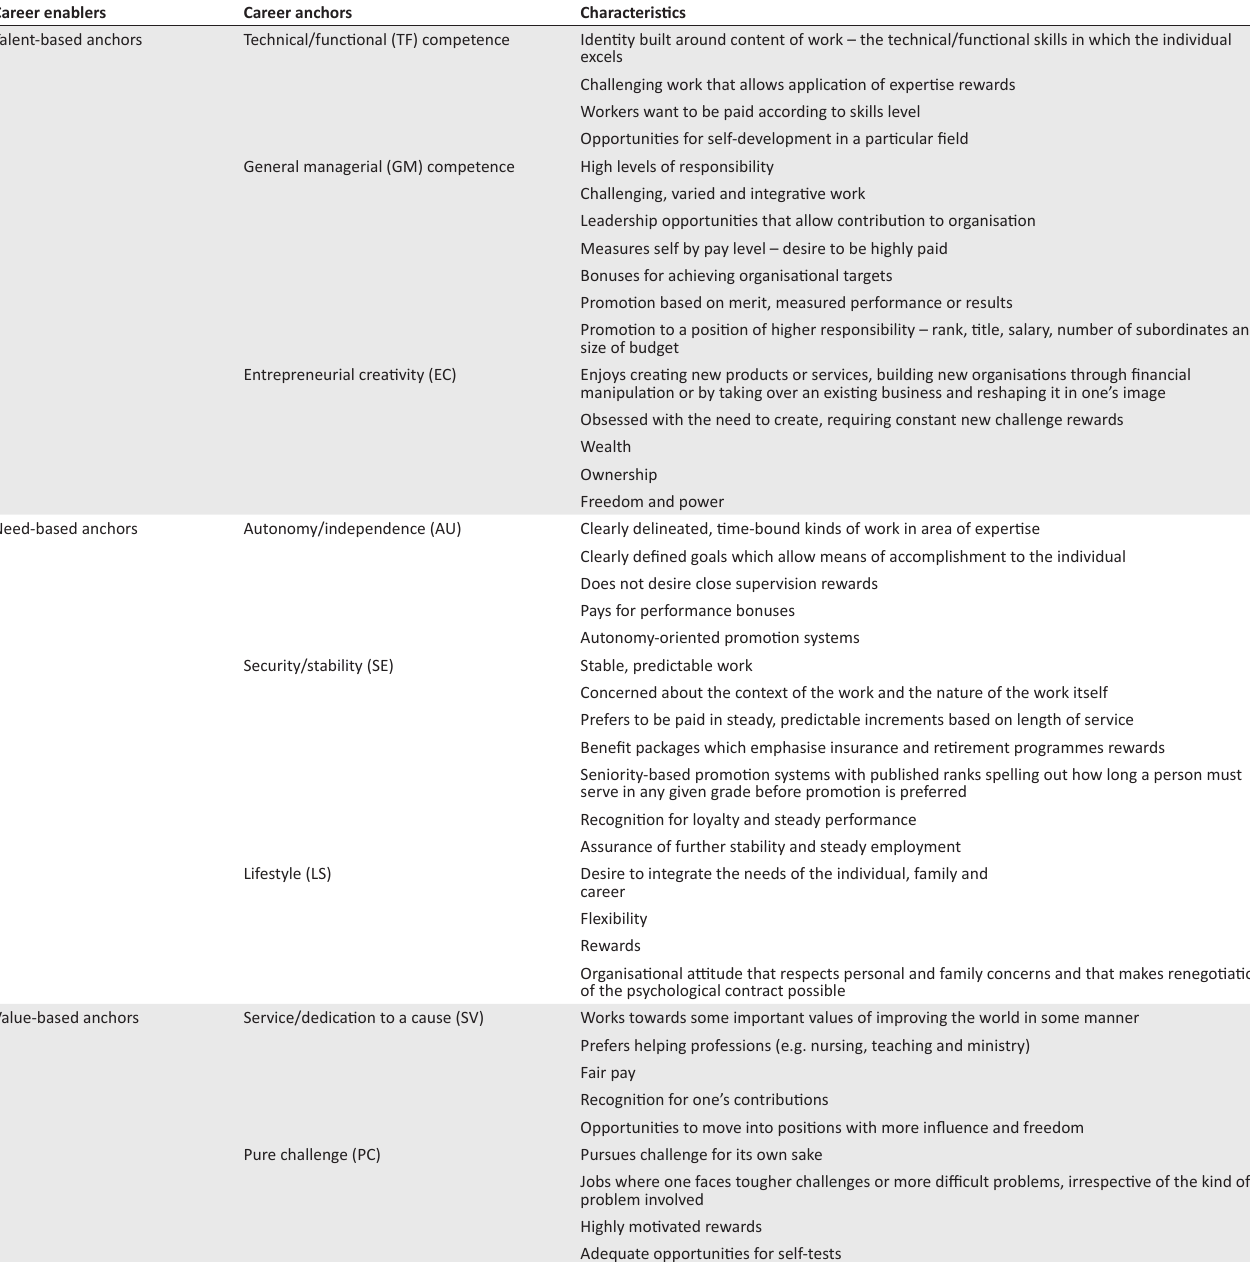
TABLE 1: Characteristics of the eight career